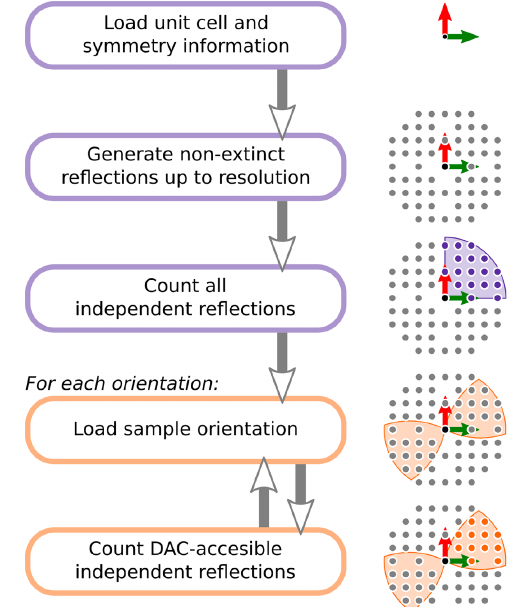
Figure 2 with the opening C Procedure for potency evaluation using Hikari . In this example reciprocal space has mm point-group symmetry, there are 17 non-extinct symmetry- independent reflections (purple), 12 of which can be found within the DAC-accessible region (orange). Thus the potency of this experimental setup is (cid:7)